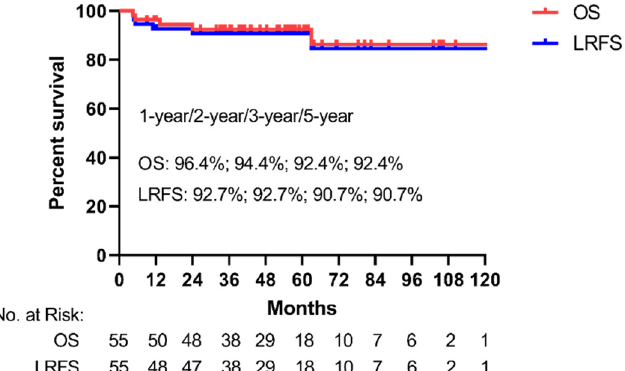
Figure 1. Kaplan–Meier analysis of local recurrence-free survival (LRFS) and overall survival (OS) of all patients. The percent survival of 1-, 2-, 3- and 5-year of LRFS and OS rate and the number at risk are also presented.